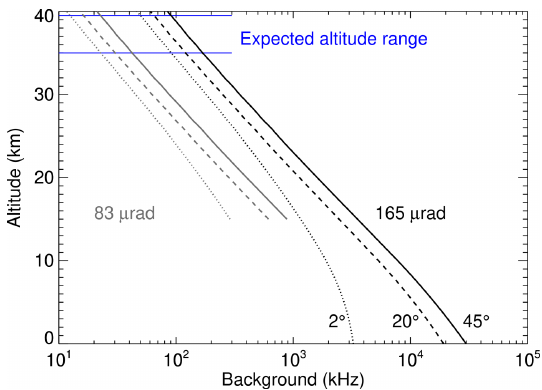
Figure 5. Simulated background photon-counting rates for the 83µrad (gray) and 165µrad (black) telescope FOV and 2, 20, and 45 ◦ solar elevation angles. The 165µrad FOV was eventually used during the